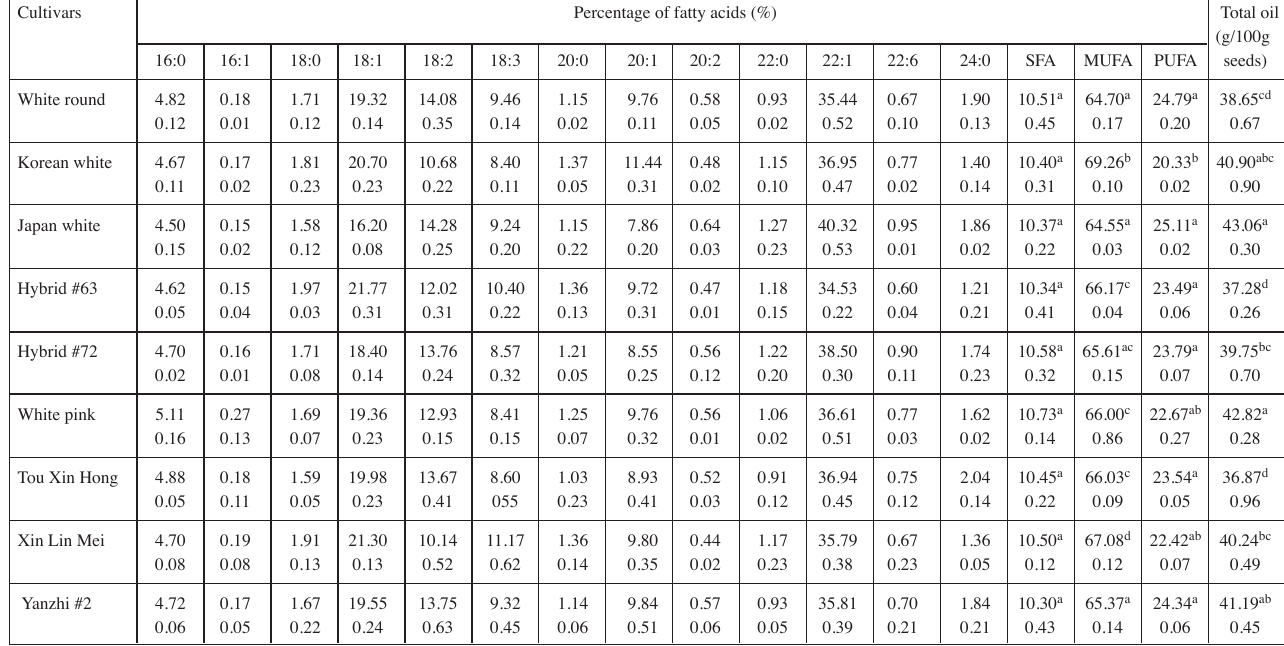
Tab. 2: Fatty acid composition and total oil content of radish seeds Cultivars Percentage of fatty acids